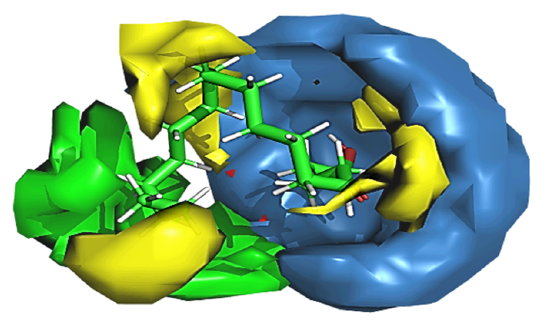
Figure 15. Contour map of best hit compound chlorogenic